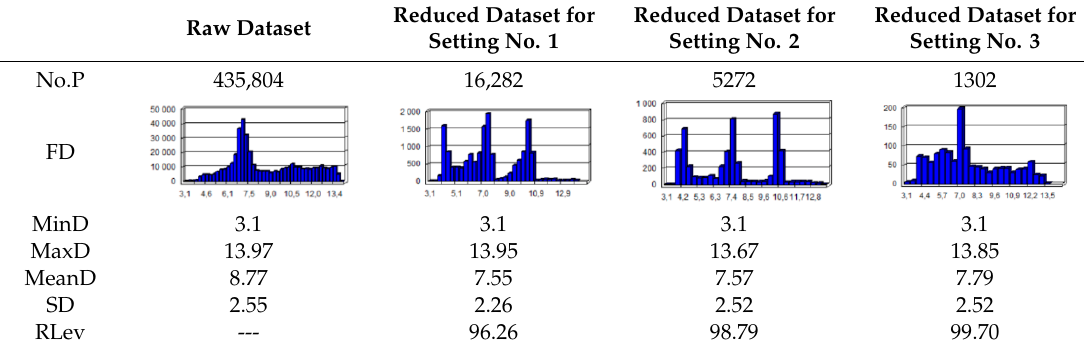
Table 5. Statistics for points reduced with the OptD method based on the Inski canal area.